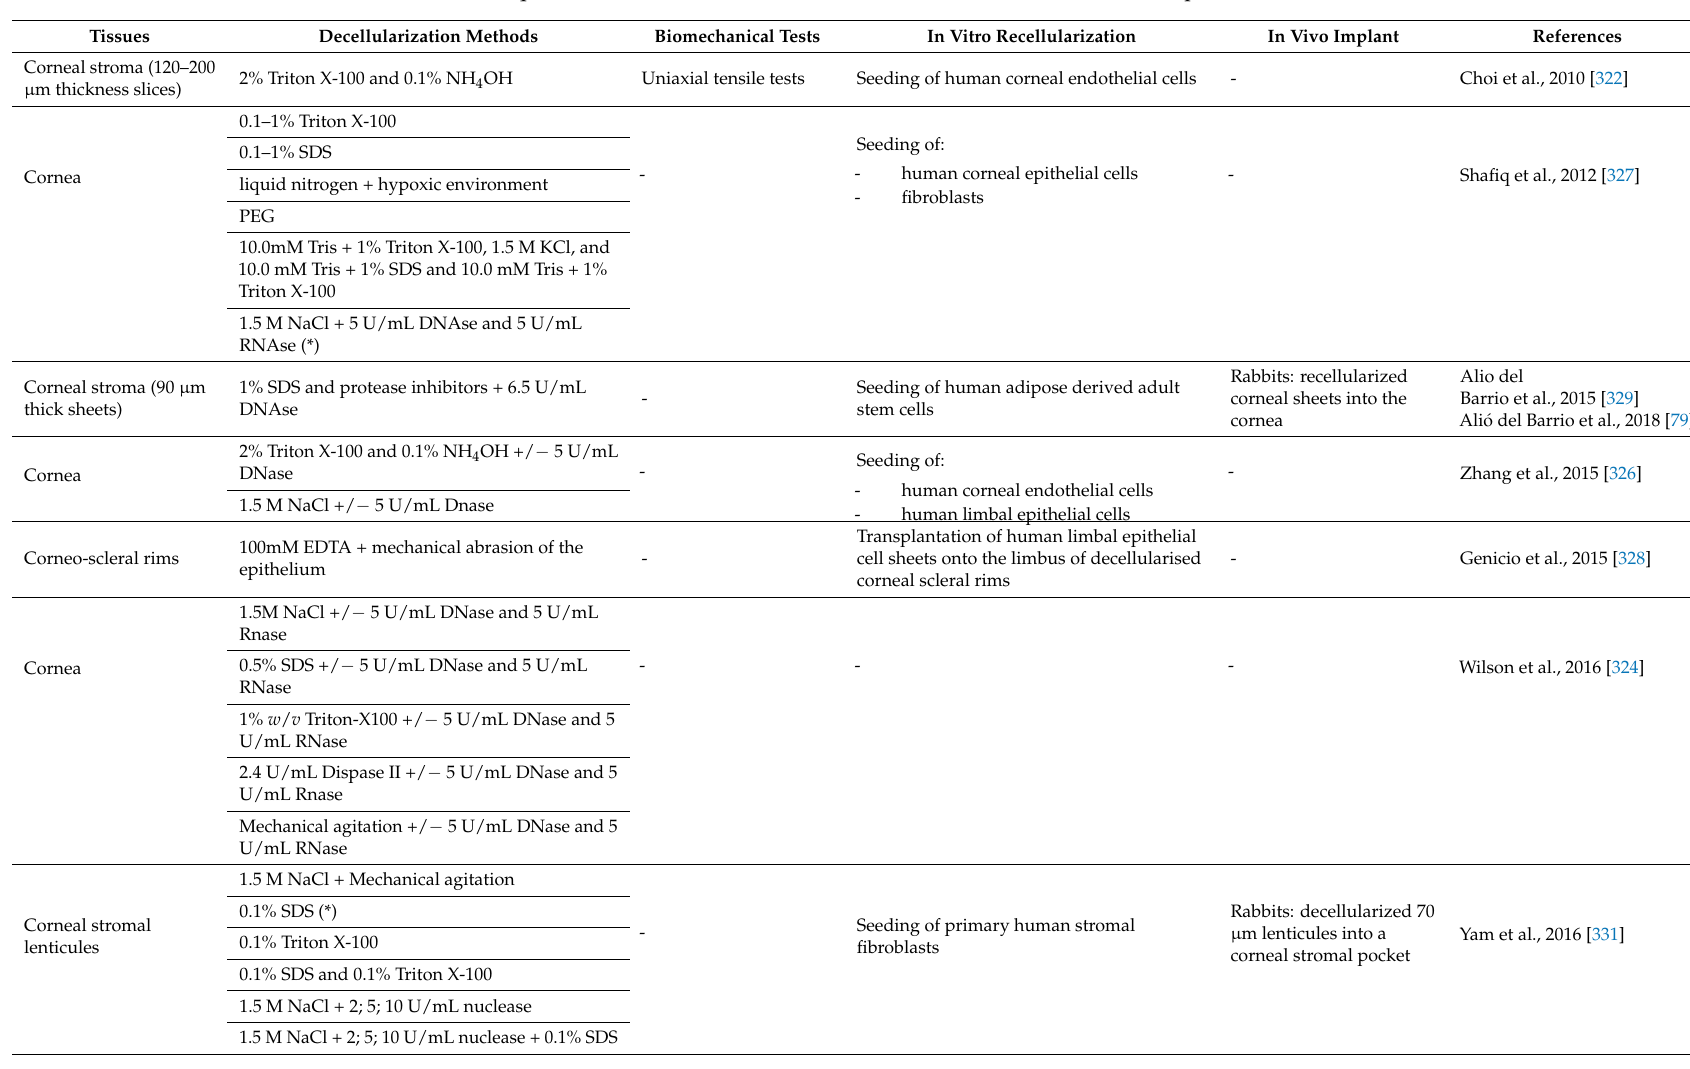
Table 13. Cornea. Decellularization techniques, biomechanical tests, recellularization methods, and in vivo implant of human corneal extracellular